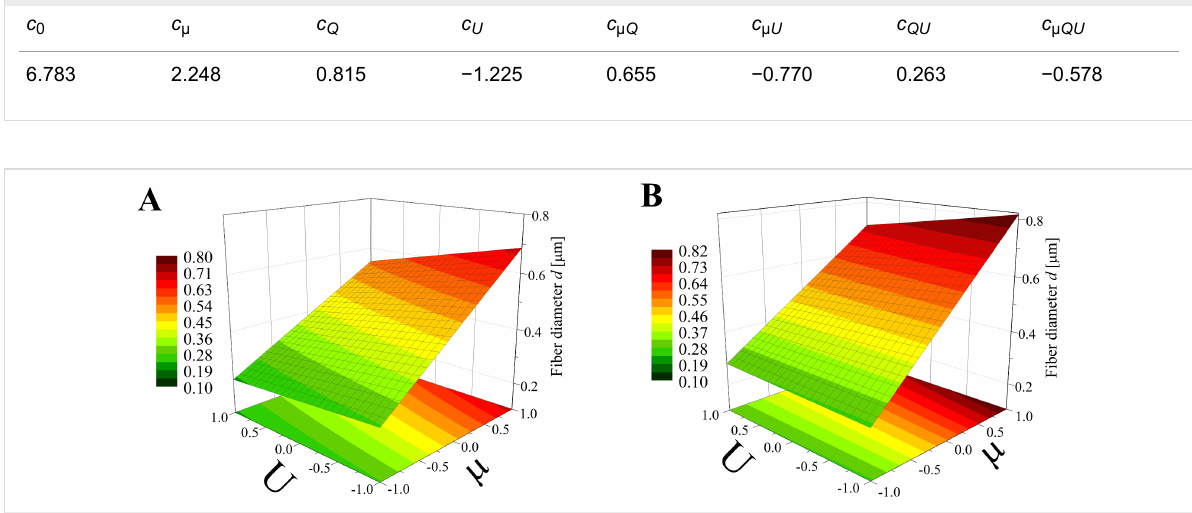
Figure 8: Response surface plots presenting the dependence of the diameter of the obtained beaded fibers ( d ) on the electrical voltage ( U ) and the dynamic viscosity (µ) of the polymer solution for (A) minimum flow rate ( Q = − 1) and (B) maximum flow rate ( Q = +1) .